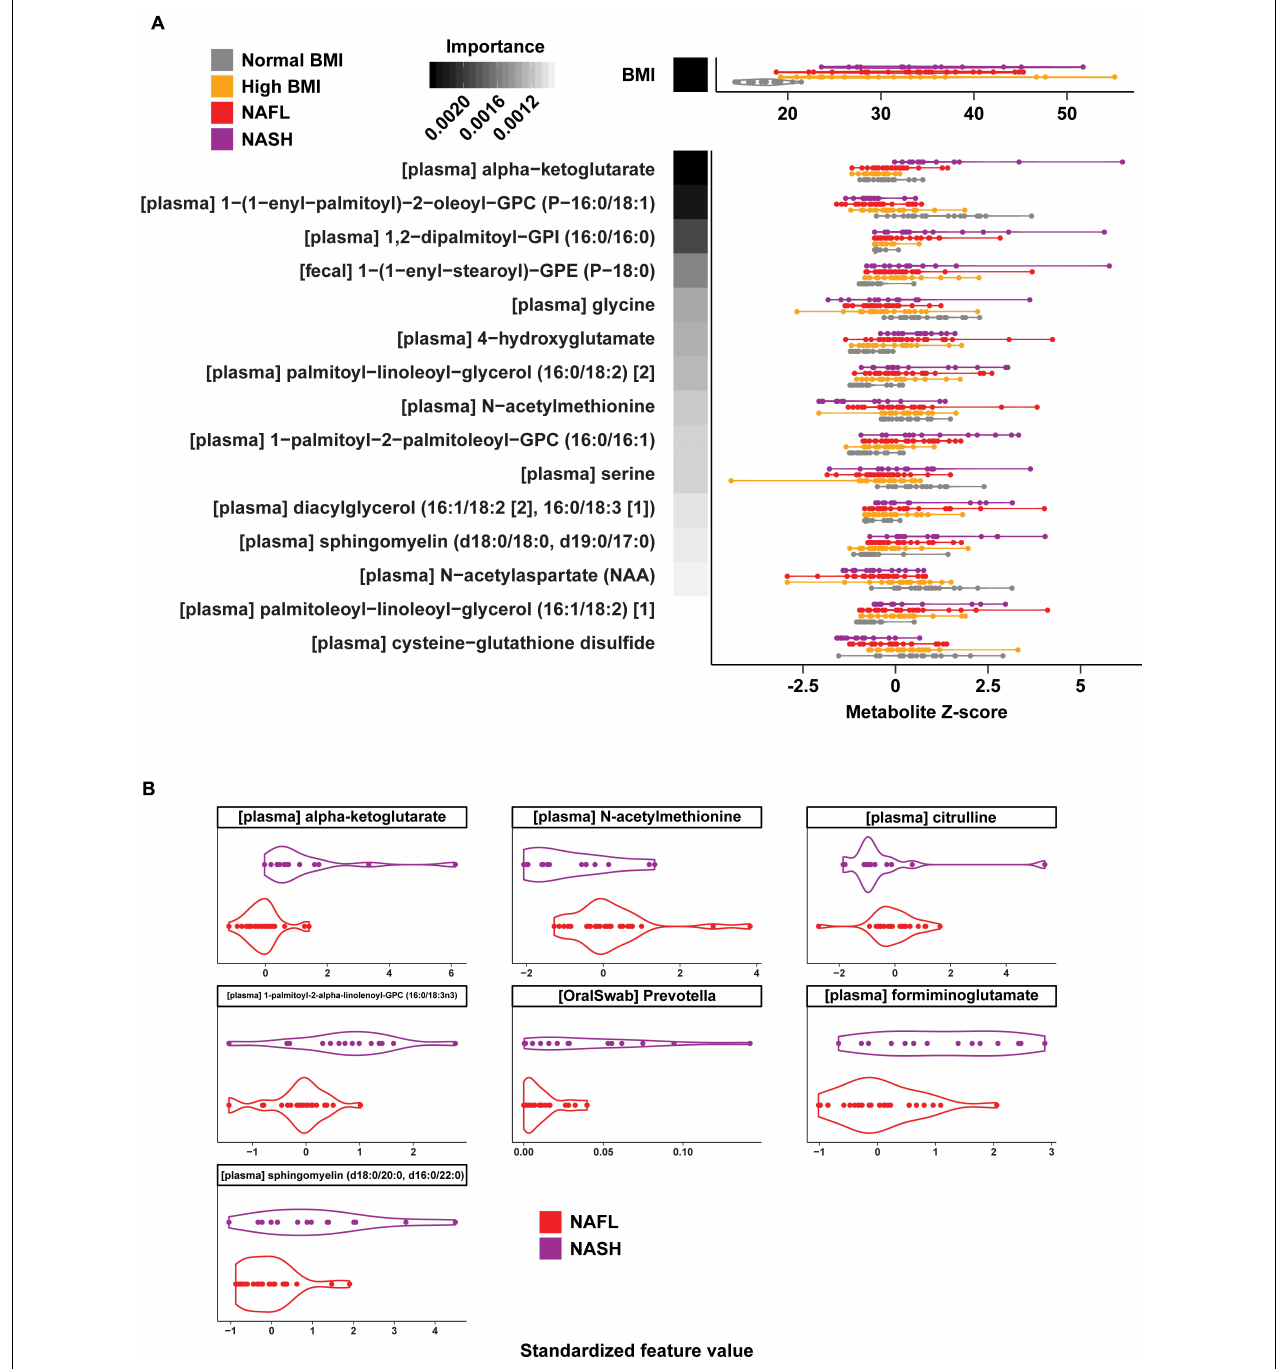
FIGURE 5 | Multi-omic classification models using metabolomics and 16S microbiome profiling data. (A) Distribution of BMI and standardized values for the features selected in the multiclass multi-omic RF model (violin plots). RF model importance values are shown as shaded boxes with darker colors denoting higher mean importance. Text in brackets denote the source of each selected feature (plasma or fecal metabolite). (B) Distribution of standardized values for the features selected in the NAFL vs. NASH multi-omic RF model (violin plots). Text in brackets denote the source of each selected feature.